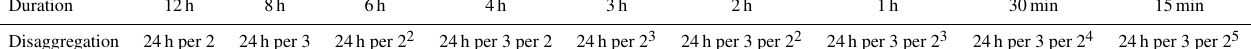
Table 2. The disaggregation scheme applied to the daily data (DS) to obtain rainfall volumes at the given durations. Duration